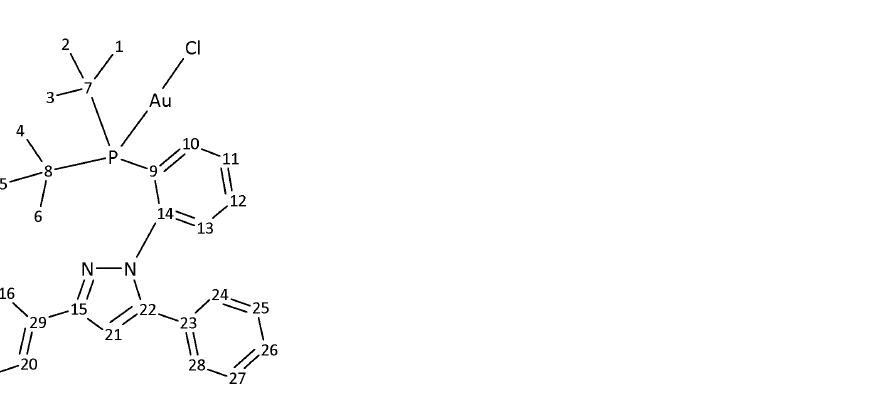
Figure 2. Complexes [Au(TrippyPhos)Cl] ( 1 ) with the numbering of the relevant atoms for the assignment of the appropriate to NMR data. Table 1. 1 H, 13 C and 31 P nuclear magnetic resonance (NMR) chemical shifts of [Au(TrippyPhos)Cl] ( 1 ) complex and TrippyPhos in CDCl 3 . The coordination shifts are shown in parentheses *.